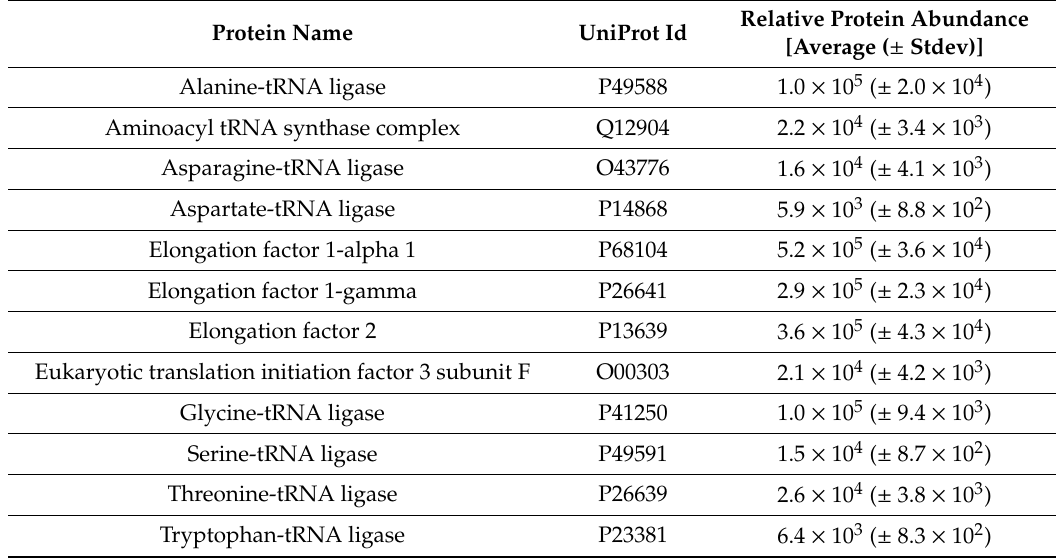
Table 2. Key proteins associated with protein translation identified in unwounded hCE-TJ-derived